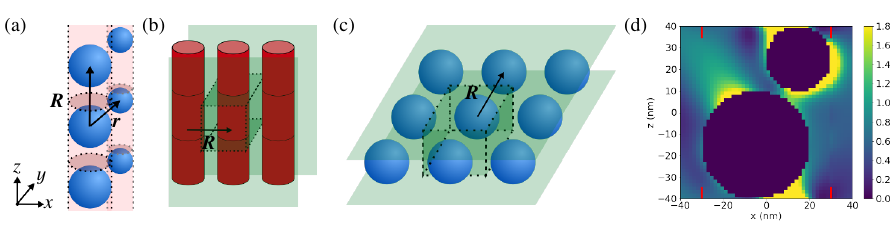
Figure 1. Panels (a) to (c) show the di ff erent possible layouts for transitions between SWs, CWs, and PWs which are color-coded in blue, green, and red. In each sketch one unit cell is highlighted. In panel (a) the unit cell contains two scatters. Panel (d) shows the simulated intensities for the arrangement in panel (a) under a PW illumination with along (sin π electric fields between the red marks are calculated directly with Ewald’s method, outside it is much faster to use the e ffi cient CW description. The lack of a discontinuity between these domains shows the accurate match of both